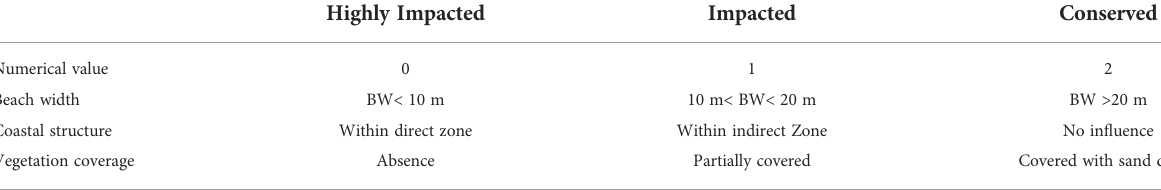
TABLE 2 Beach width, coastal structure and vegetation coverage threshold values used in the CRIfRS.